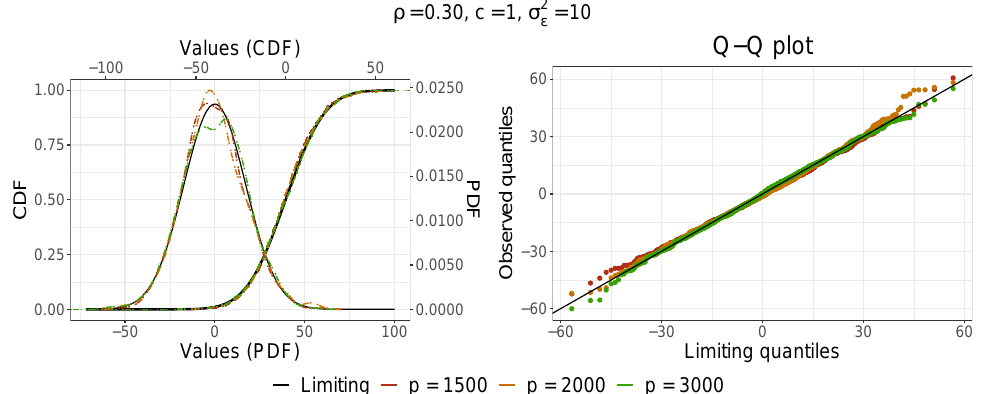
Figure 4. Comparison of the PDF and CDF ( left ) and the corresponding Q-Q plots ( right ) after 1000 replications from the Monte Carlo simulation of the statistic (80) with the limiting distribution N ( 0, s 2 ) by the Corollary 2 (in black) for (cid:36) = 0.3, c = 1, σ 2 = 10 and p = ε